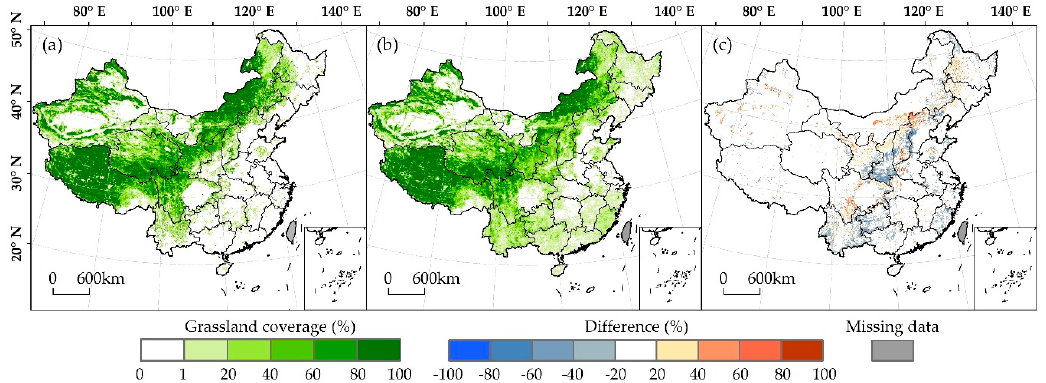
Figure 8. Spatial patterns of grassland cover in 2000: our reconstruction ( a ), CLUDs ( b ), and the difference between them ( c ).